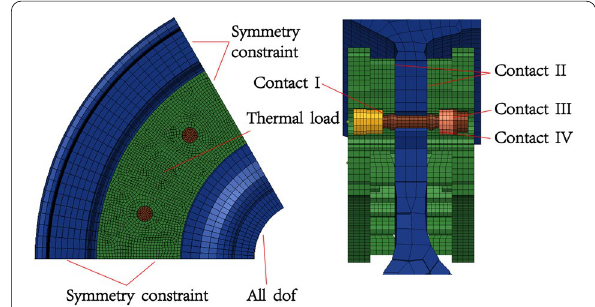
Figure 3 Finite element